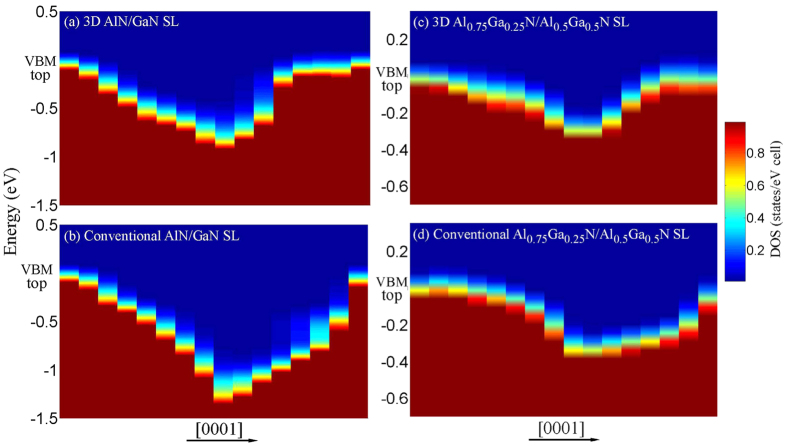
Projected DOS of valence bands along the [0001] direction for each bilayer in undoped 3D AlN/GaN SL (a), conventional AlN/GaN SL (b) 3D Al0.75Ga0.25N/Al0.5Ga0.5N SL (c), and conventional Al0.75Ga0.25N/Al0.5Ga0.5N SL (d).